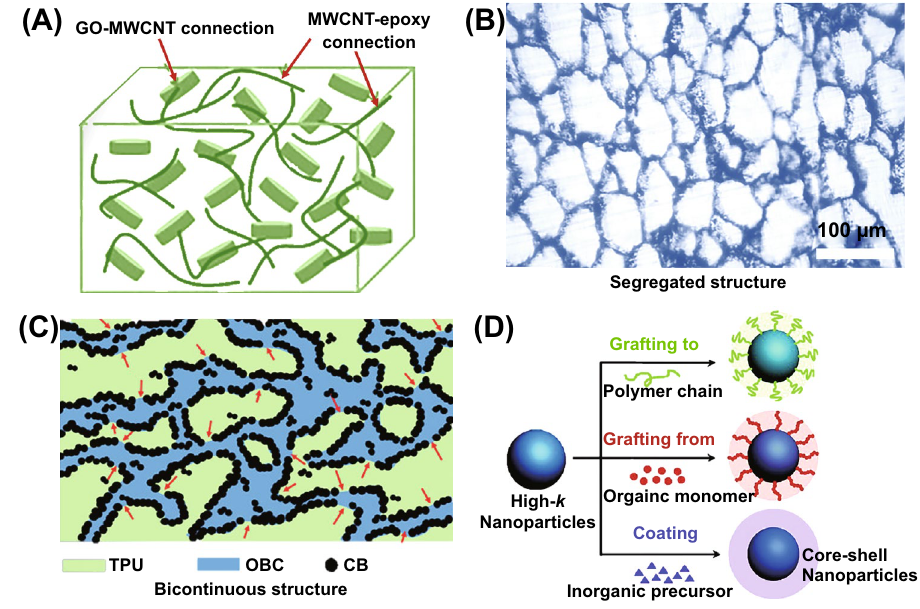
Fig. 2 A The construction of network structure with hybrid fillers containing graphene oxide/multi-walled carbon nanotube (GO/MWCNT)/ epoxy composite. Reprinted with permission from Ref. [50]. B Filler particles are localized at the boundaries between the polymer grains to form segregated system. Reprinted with permission from Ref. [53]. C Graphical representation of the network morphology evolution for olefin block copolymer/carbon black/thermoplastic polyurethane (OBC/CB/TPU)- ternary blends composites. Reprinted with permission from Ref. [56]. D General methods associated with filler surface modification. Reprinted with permission from Ref.